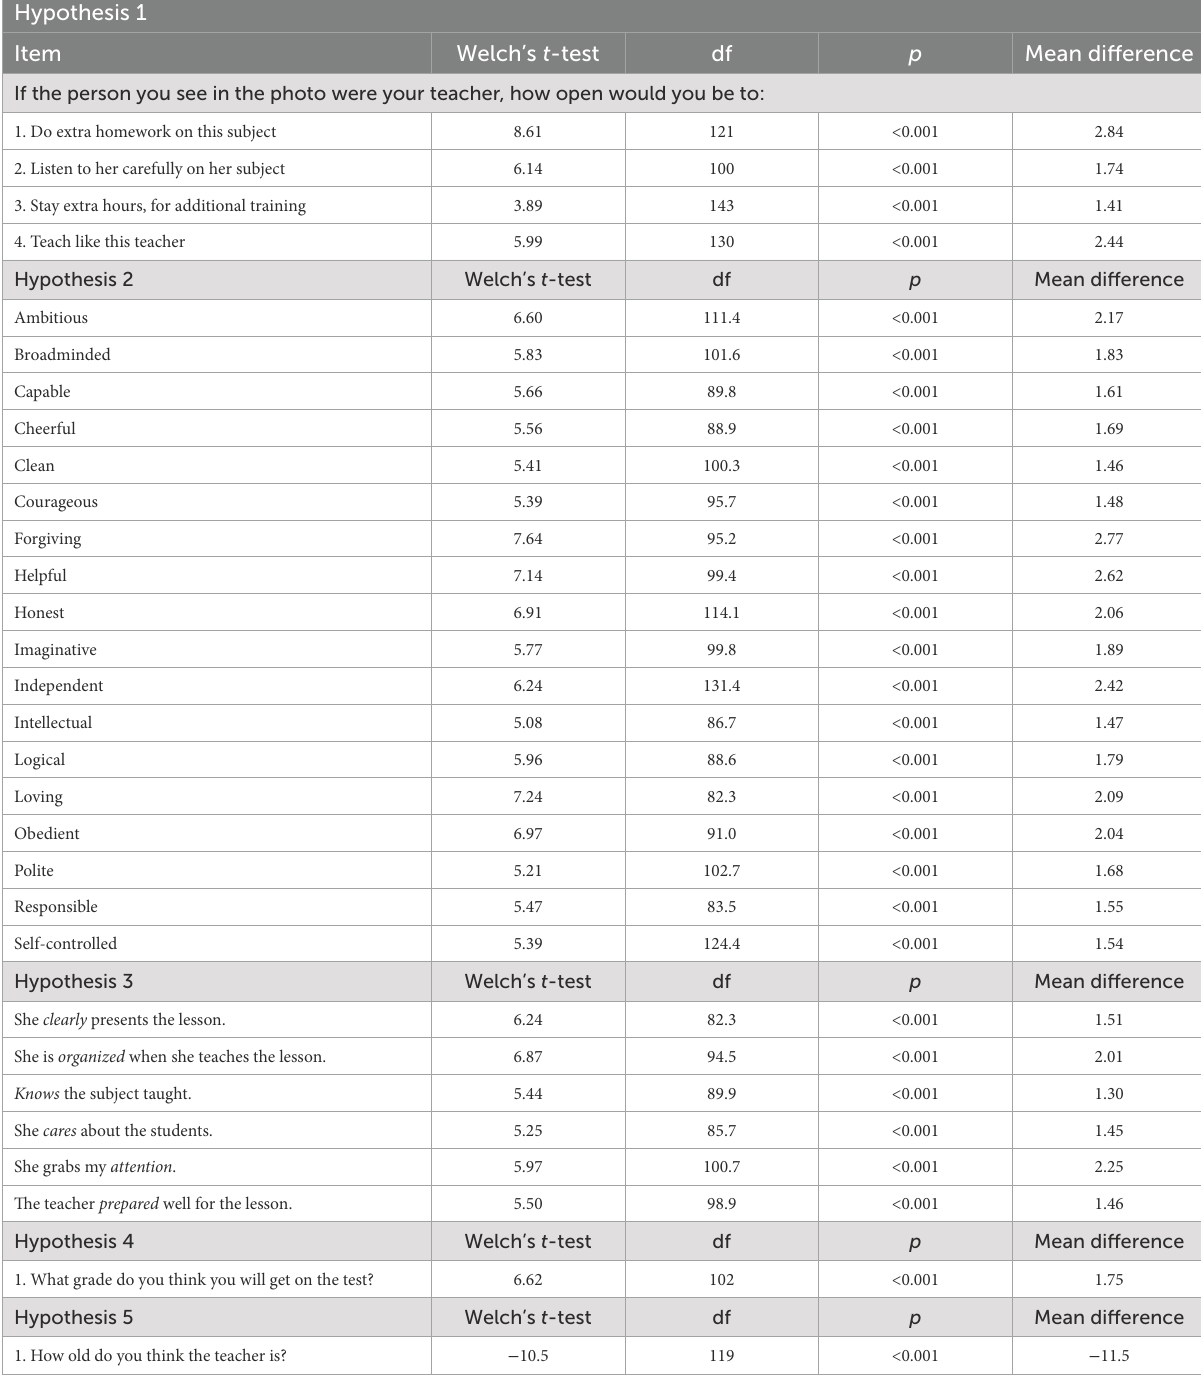
Table created with Microsoft Word, based on the Jamovi